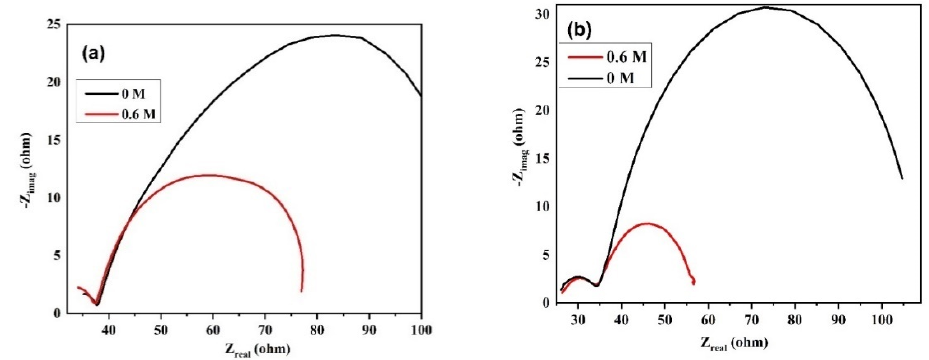
Figure 8. Nyquist plot of ( a ) NiO-ZrO 2 /FTO and ( b ) NiO-Y 2 O 3 /FTO thin film in the absence and presence of 0.6 M methanol. presence of 0.6 M